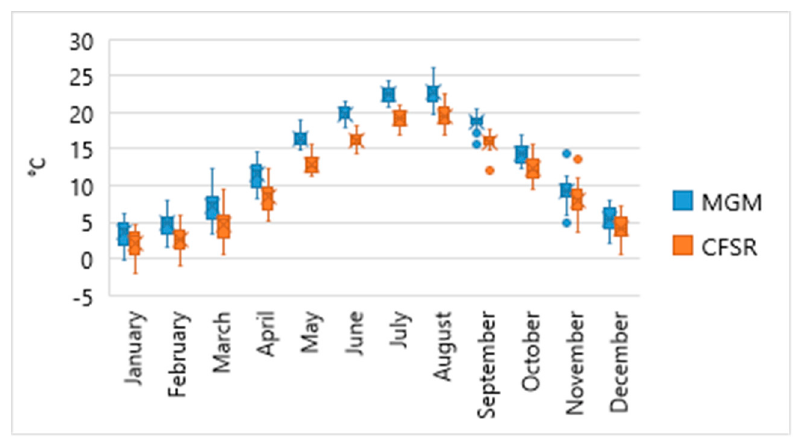
Figure 4. Monthly distribution of temperature for CFSR and MGM datasets.